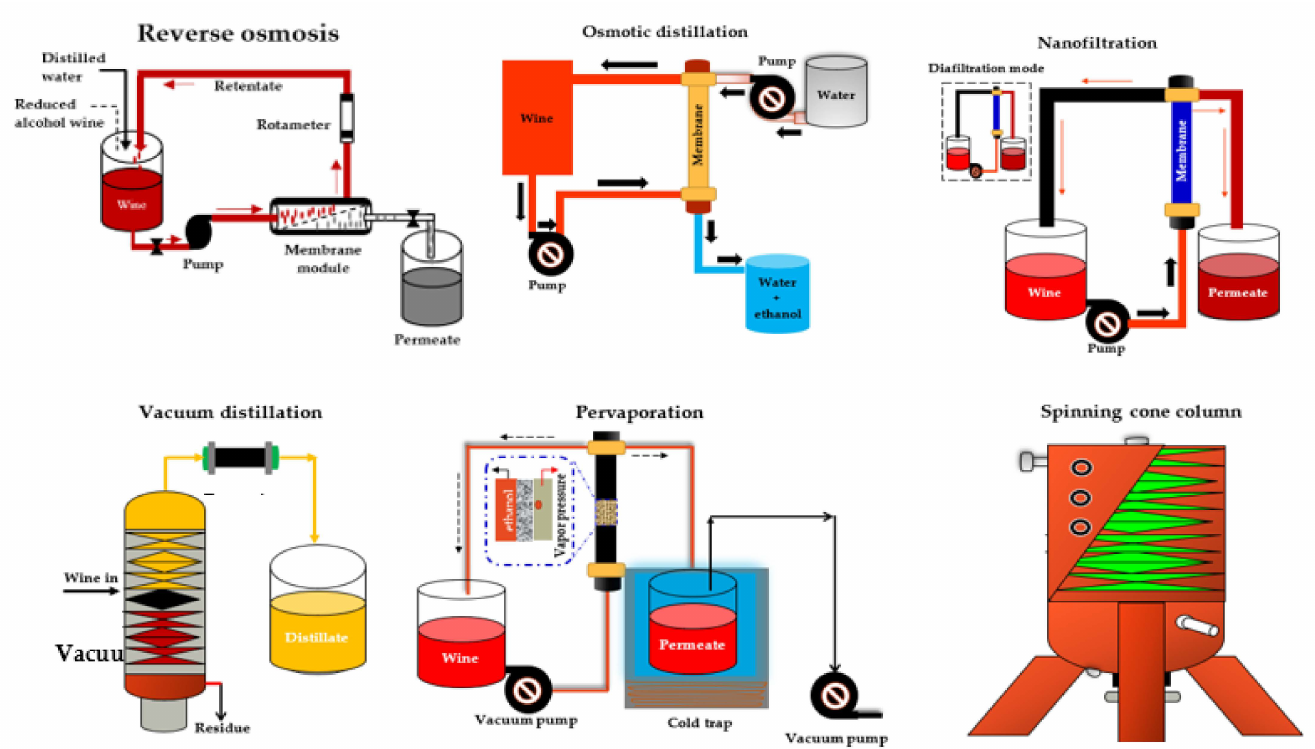
Figure 2. Scheme of different integrated systems for wine dealcoholization. Adapted from Salgado et al. [80], Catarino and Mendes [158], Pham et al. [168], and Liguori et al.